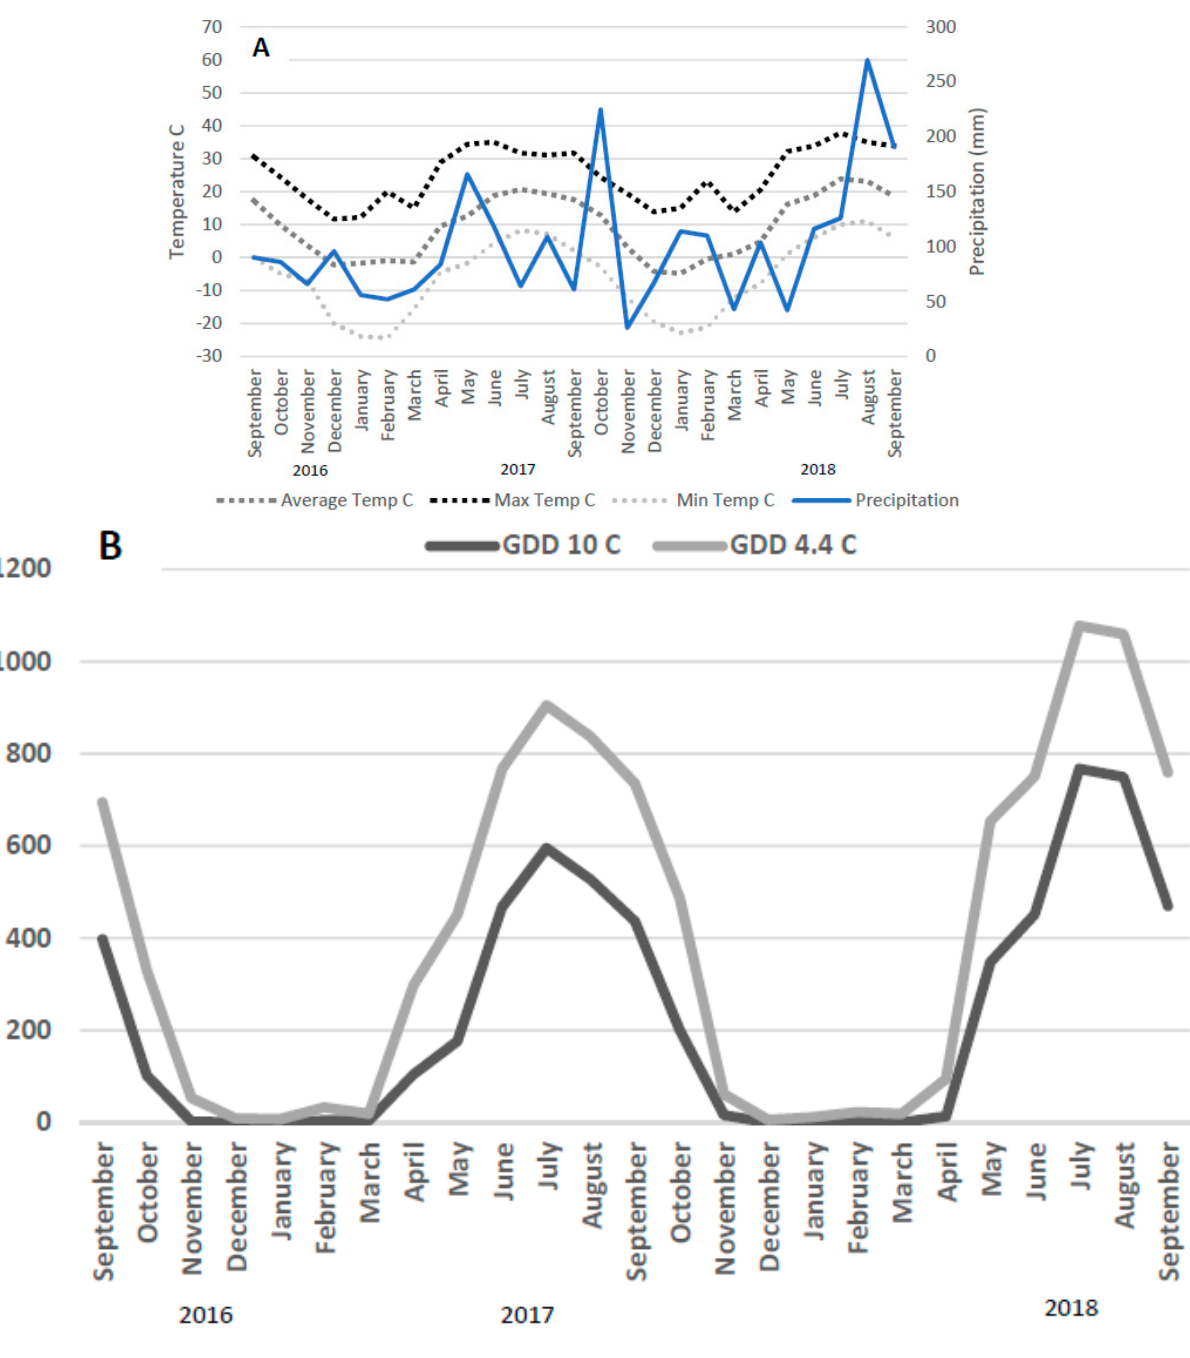
Figure 1. ( A ) Minimum, maximum, and average temperatures ( ◦ C) at experimental site (2016–2018); ( B ) accumulated GDDs at experimental site (2016–2018). GDDs: growing-degree days.